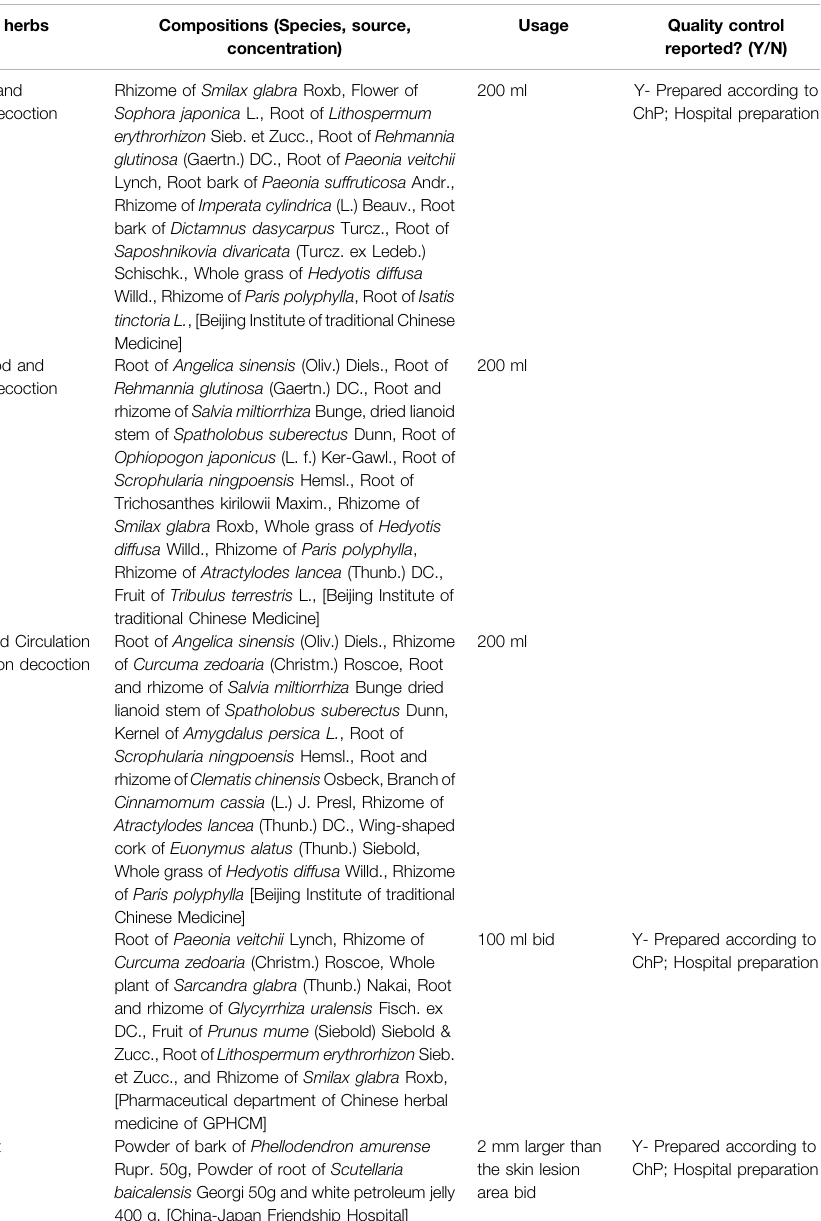
TABLE 1 | ( Continued ) Summary of the characteristics of the included